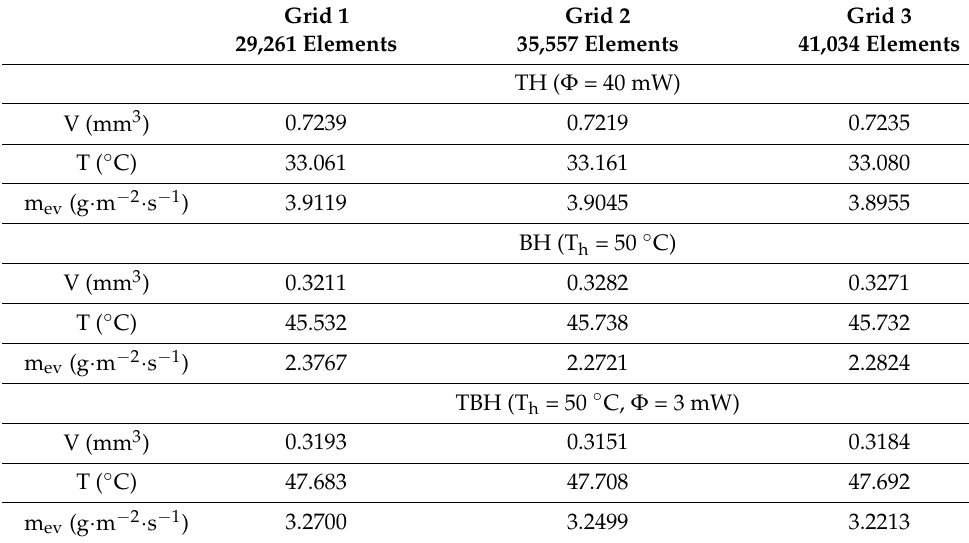
Table 1. Mesh stability (V 0 = 1 mm 3 , θ = 90 ◦ , t = 100 s). Grid